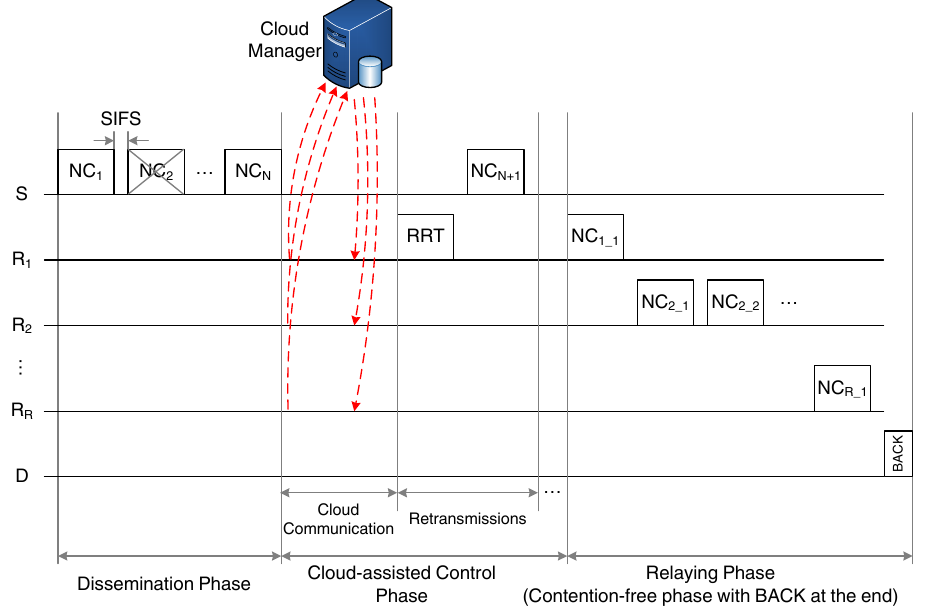
Figure 5. Example of the cloud-assisted random linear network coding (RLNC)-based (CLNC)-MAC transmission